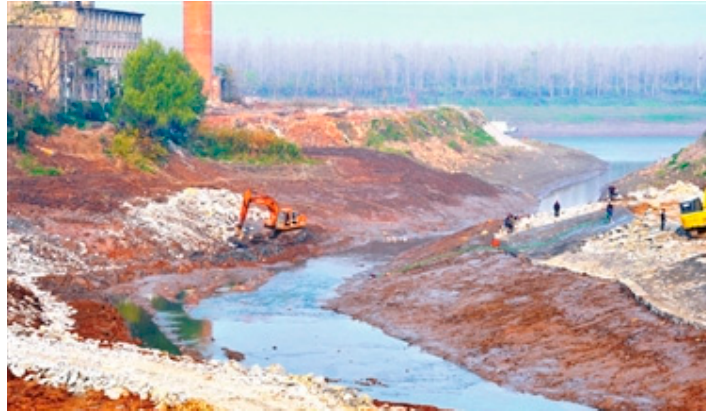
Figure 1. A site of superfine river sand silted up causing a river blockage in China.